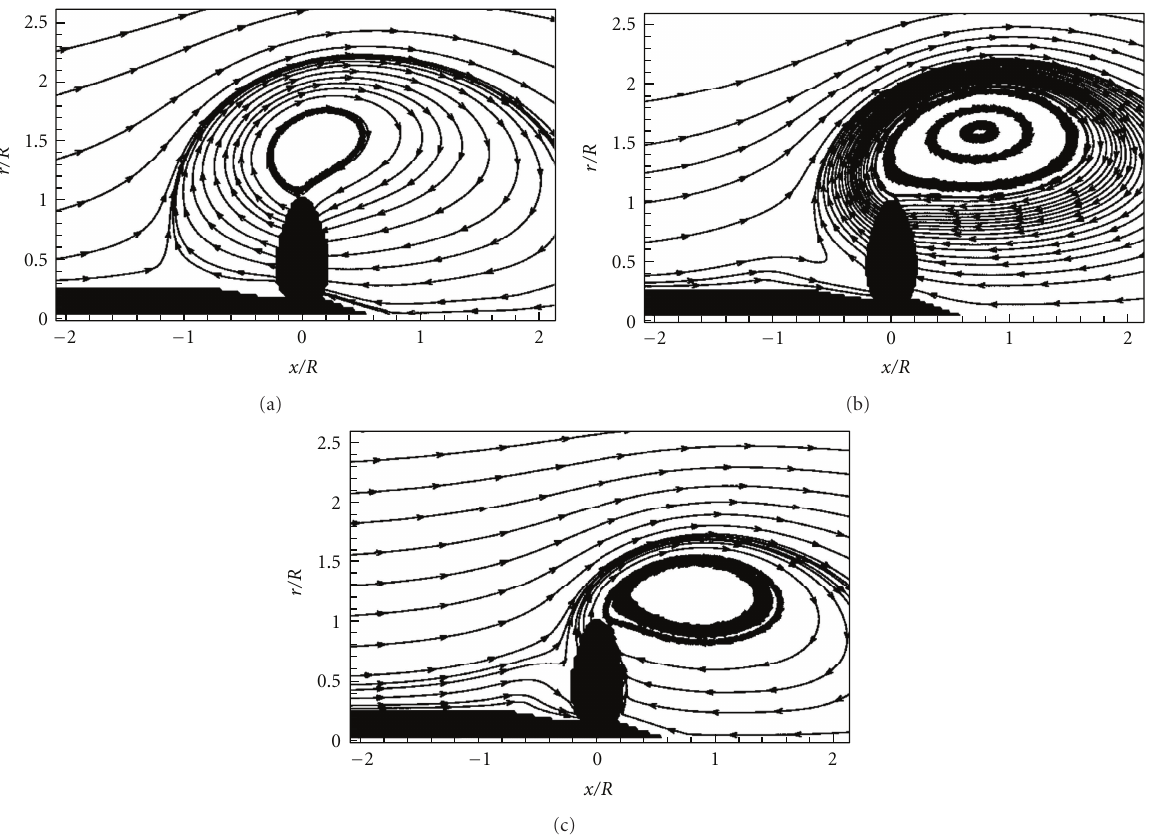
Figure 7: Circumferentially averaged streamlines over open propulsor: (a) at J = − 0 . 5, (b) at J = − 0 . 7, and (c) at J = − 1 . 0. blades are ignored as shown in Figure 12(a) to simulate the ducted propulsor in the rotating reference frame and to isolate the e ff ect of the duct and the stator blades. The stator blades are considered using the sliding interface method in Section